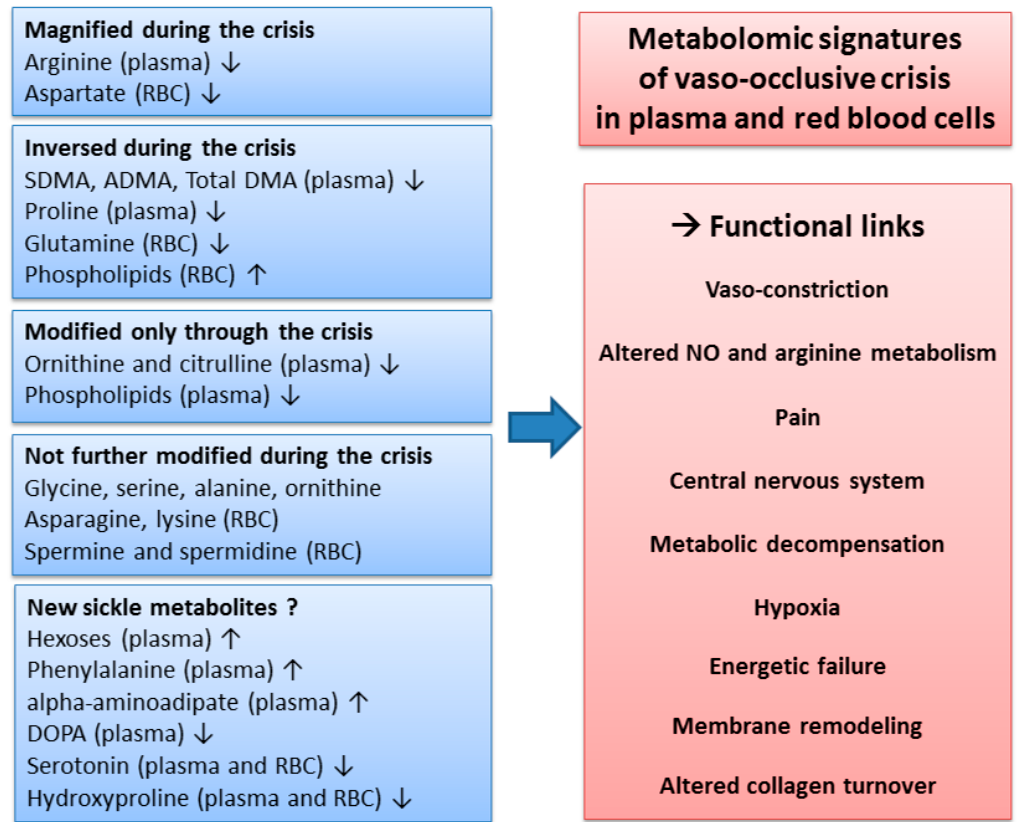
Figure 6. Overview of the metabolomic signature, with potential functional links, of the vaso-occlusive crisis, in plasma and red blood cells. The changes in metabolite concentrations during the crisis observed in our study were compared to the changes reported in the literature during the steady state. ↑ : increased concentrations; ↓ : decreased concentrations.